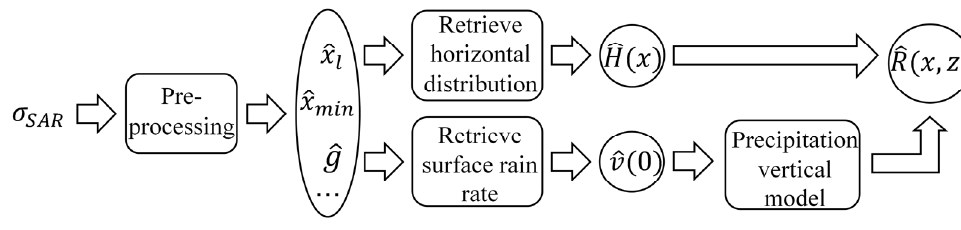
Figure 5. The process of MRA.